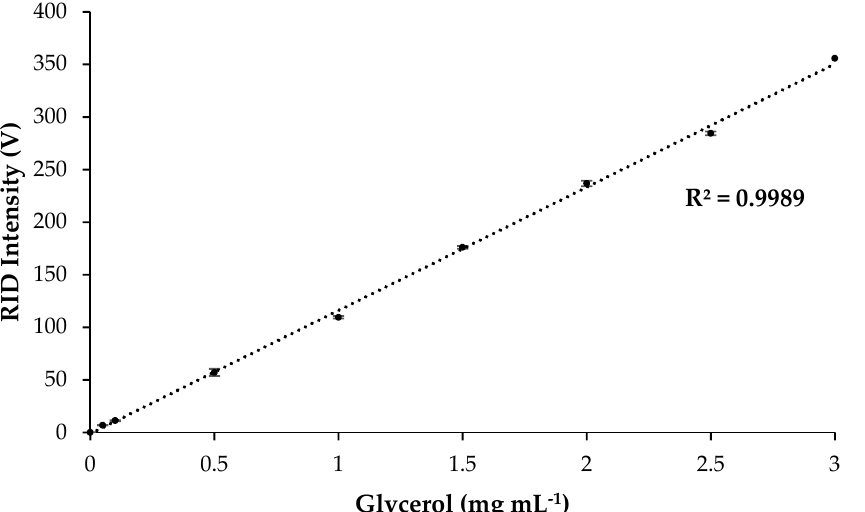
Figure 1. Calibration curve for glycerol quantification. Standards injections were tested for interday ( n = 5) and intraday ( n = 5) reliability. Error bars represent standard deviation across interday and intraday injection for each point in the calibration curve ( n = 25). LOD = 0.13 mg mL − 1 , LOQ = 0.39 mg mL − 1 .